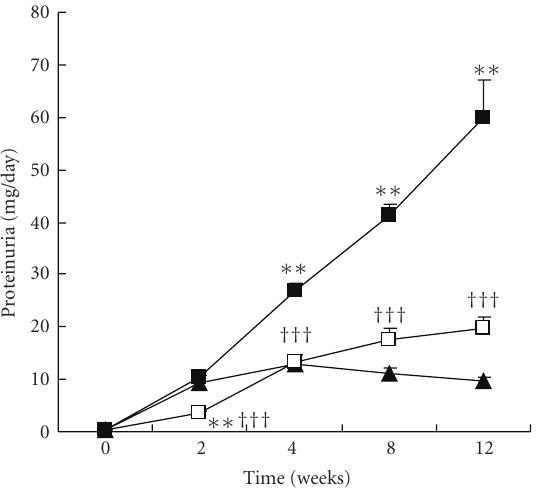
Figure 3: Changes of proteinuria. WKY (closed triangle), MC/MF (closed square), and HC/LF (open square). ∗∗ P < . 01, ∗∗∗ P < . 001 versus WKY; ††† P < . 001 versus